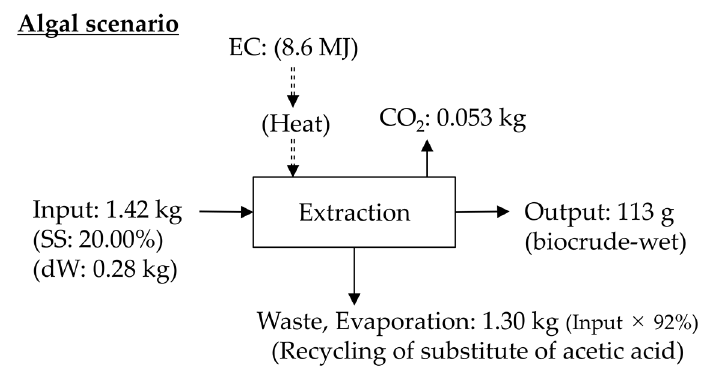
Figure 9. HTL equipment at Minamisoma (10.2 kW, 21.6 kg/day).